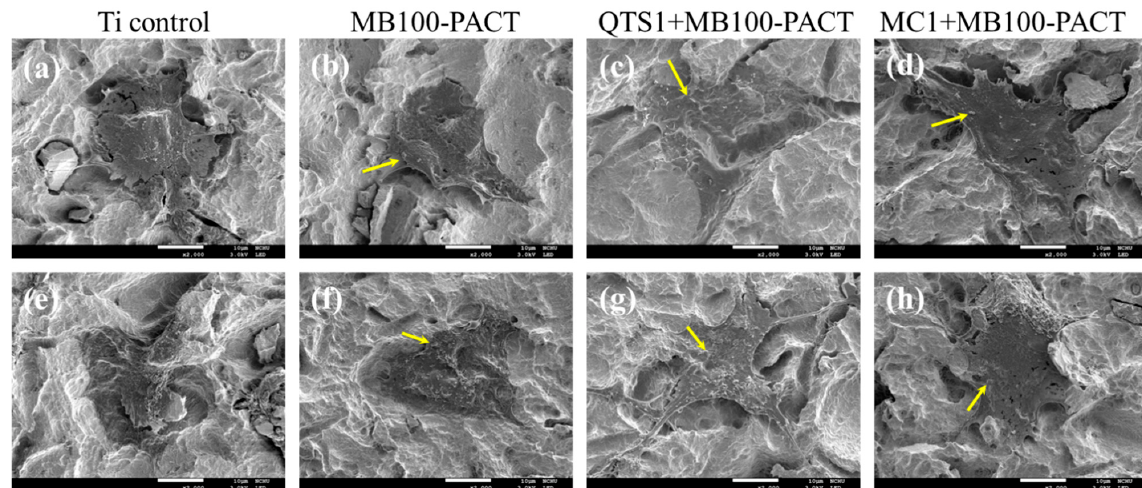
Figure 8. SEM images of MG63 cells after 6 h of culture on the ( a , e ) sterile Ti surface, ( b – d ) A. actinomycetcmcomitans -contaminated, or ( f – h ) S. mutants -contaminated surfaces treated by ( b , f ) MB100-PACT, ( c , g ) QTS1 + MB100-PACT, and ( d , h ) MC1 + MB100-PACT.